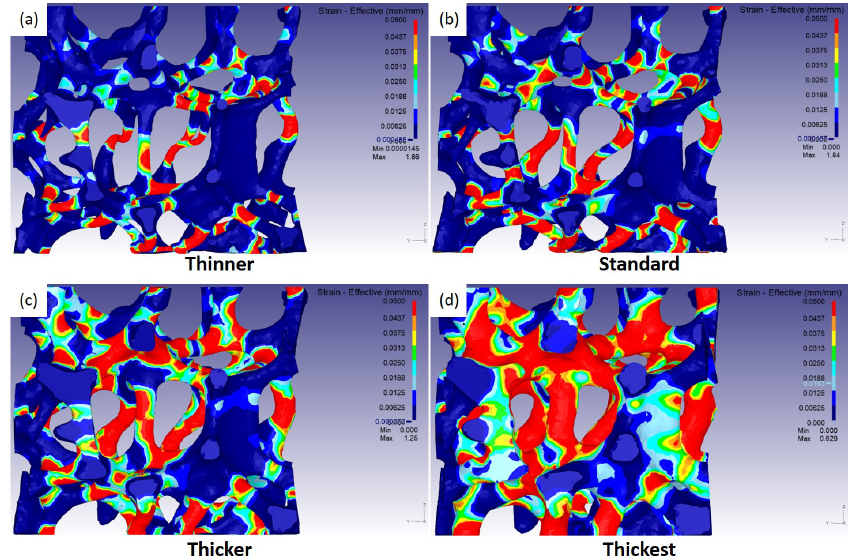
Figure 14. Distribution of effective strain of various model domains with different strut thickness at a Figure 14: Snapshot of effective strain of various model domains with different strut thickness macroscopic strain of 0.1: ( a ) thinner, ( b ) standard, ( c ) thicker, and ( d ) the thickest at a macroscopic strain of 0.1: (a) thinner, (b) standard, (c) thicker, and (d) the thickest models